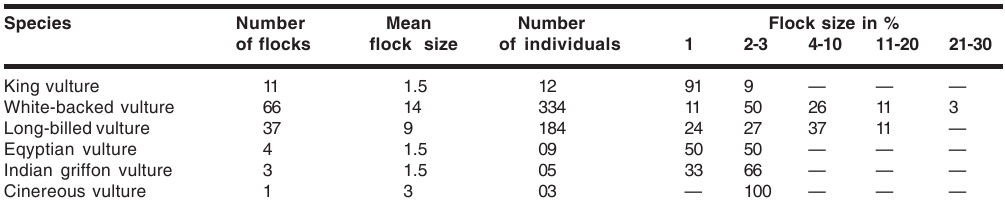
1. Number of individuals and percentage flock size recorded for six species of vultures in Pench Tiger Reserve (2006-2008) Species